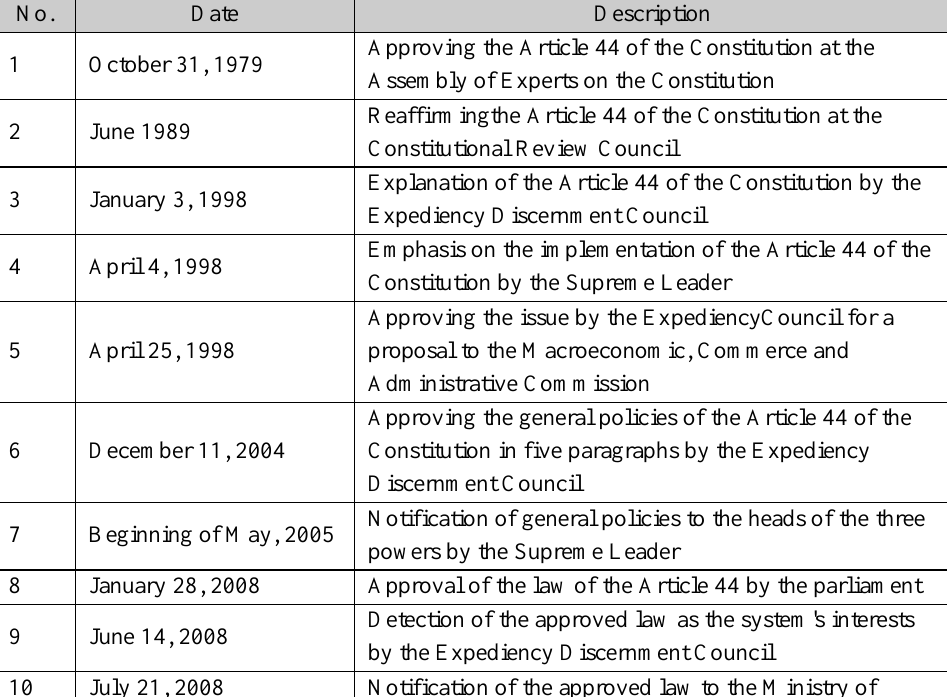
Table 7: Important dates in the privatization program in the Iranian economy